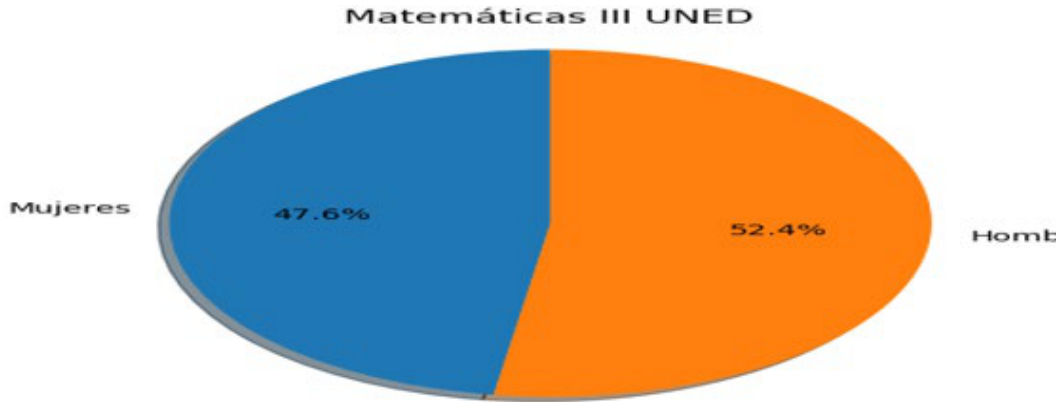
Figure 4. Female students vs. male students in the other subject